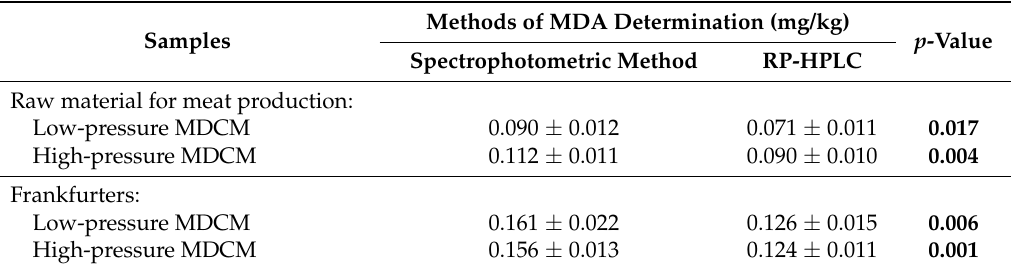
Table 3. Malondialdehyde concentration in experimental samples determined by modified TBA spectrophotometric method and RP-HPLC (means ±